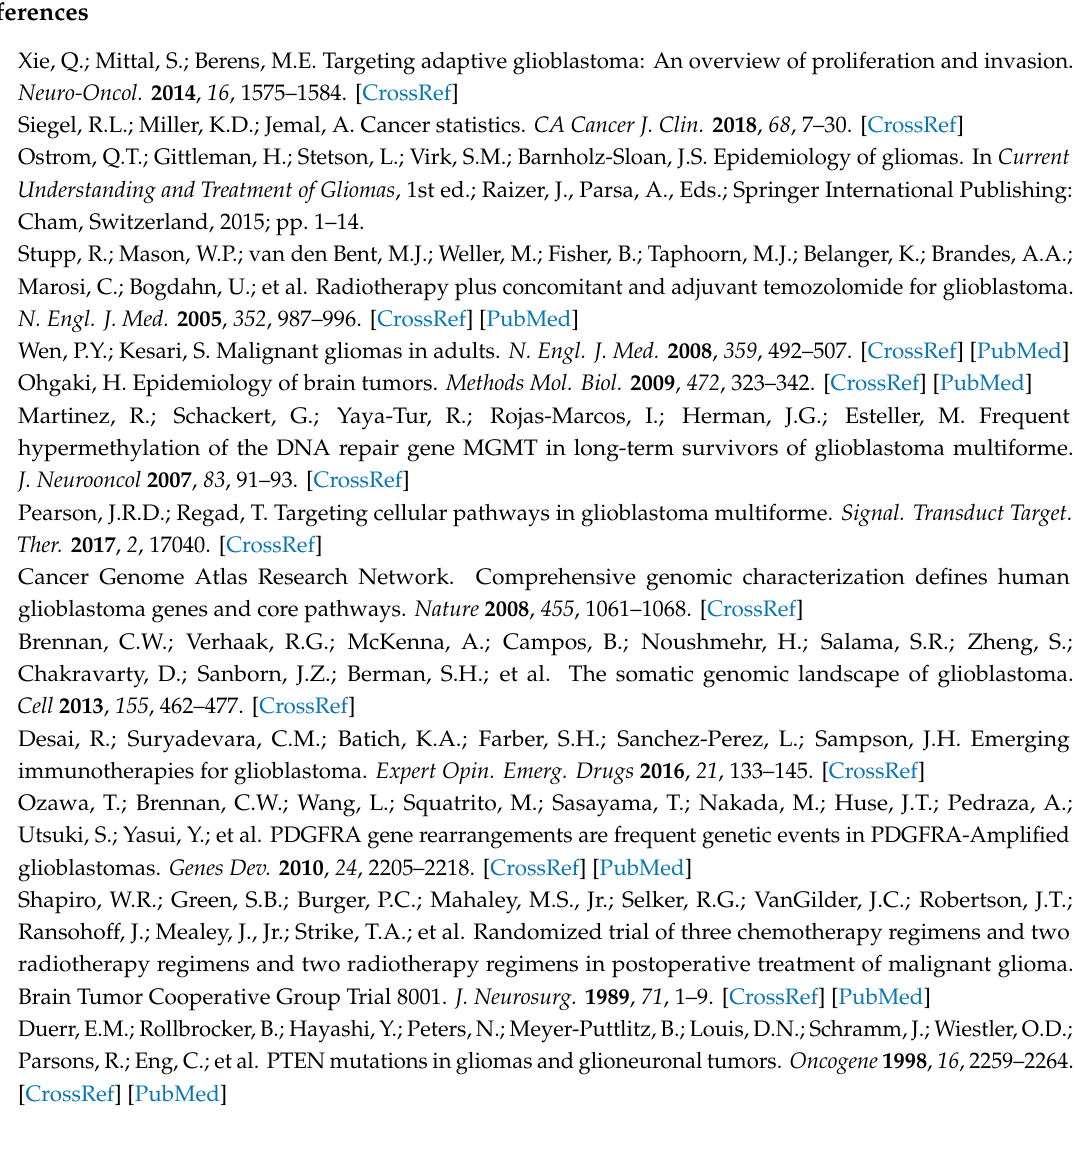
Figure S1: E ff ects of TCDD, OME, and ESO on induction of Ah-responsive genes, Table S1: Antibody and Reagents, Table S2: RT-PCR Primers, and Table S3: Treatment of Early Stage GBM PDX 15-037 with